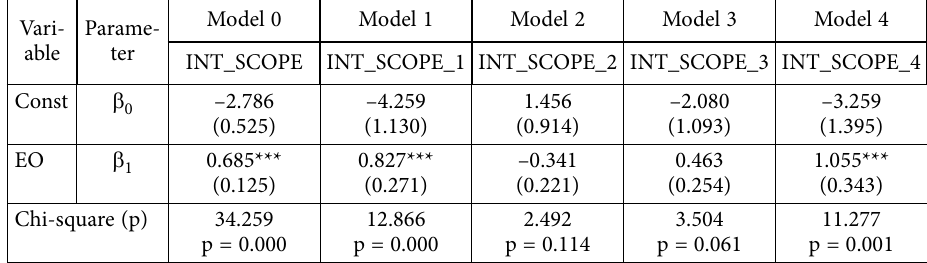
Table 5. Results of the logistic regression model for the dependent variable “innovation” (source: own elaboration based on a survey ( n = 355)) Vari- Parame- able